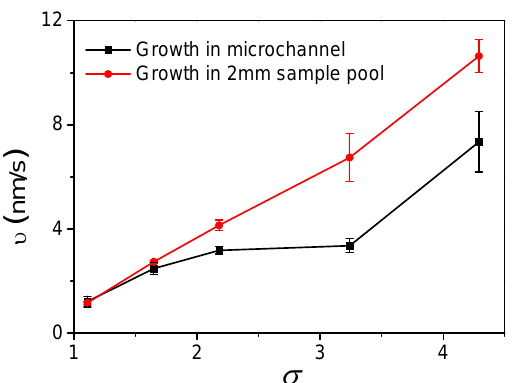
Figure 5. Comparison of the growth rates of the (110) face of the lysozyme crystals grown in the microchannel and the sample pool between 2 h and 5 h at different bulk supersaturations.